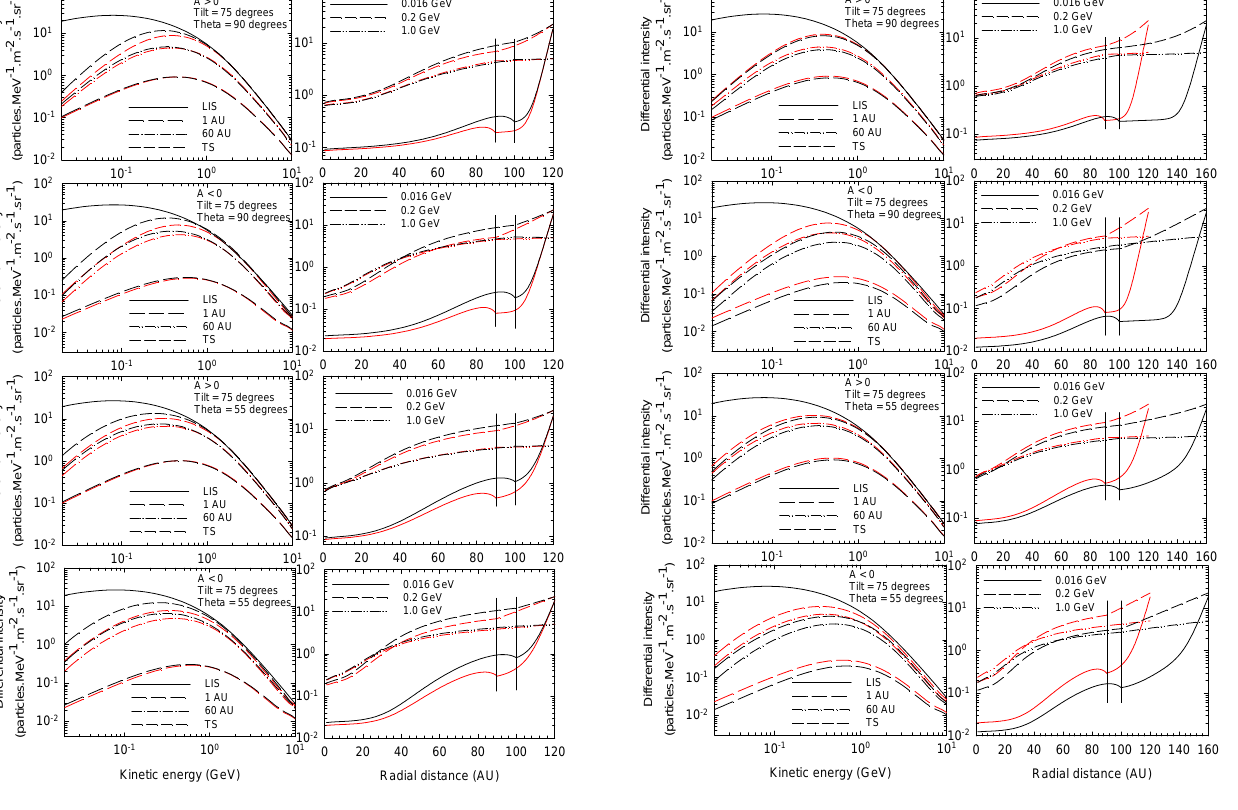
Fig. 3. Similar to Fig. 1 but with the TS positioned at 90 AU and with the heliopause at 120 AU (red curves) compared to the TS at 100 AU with the heliopause at 160 AU (black